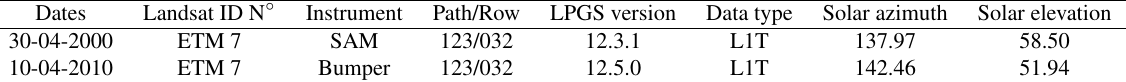
Table 1: Characteristics of the Landsat 7 images in the Chinese region.